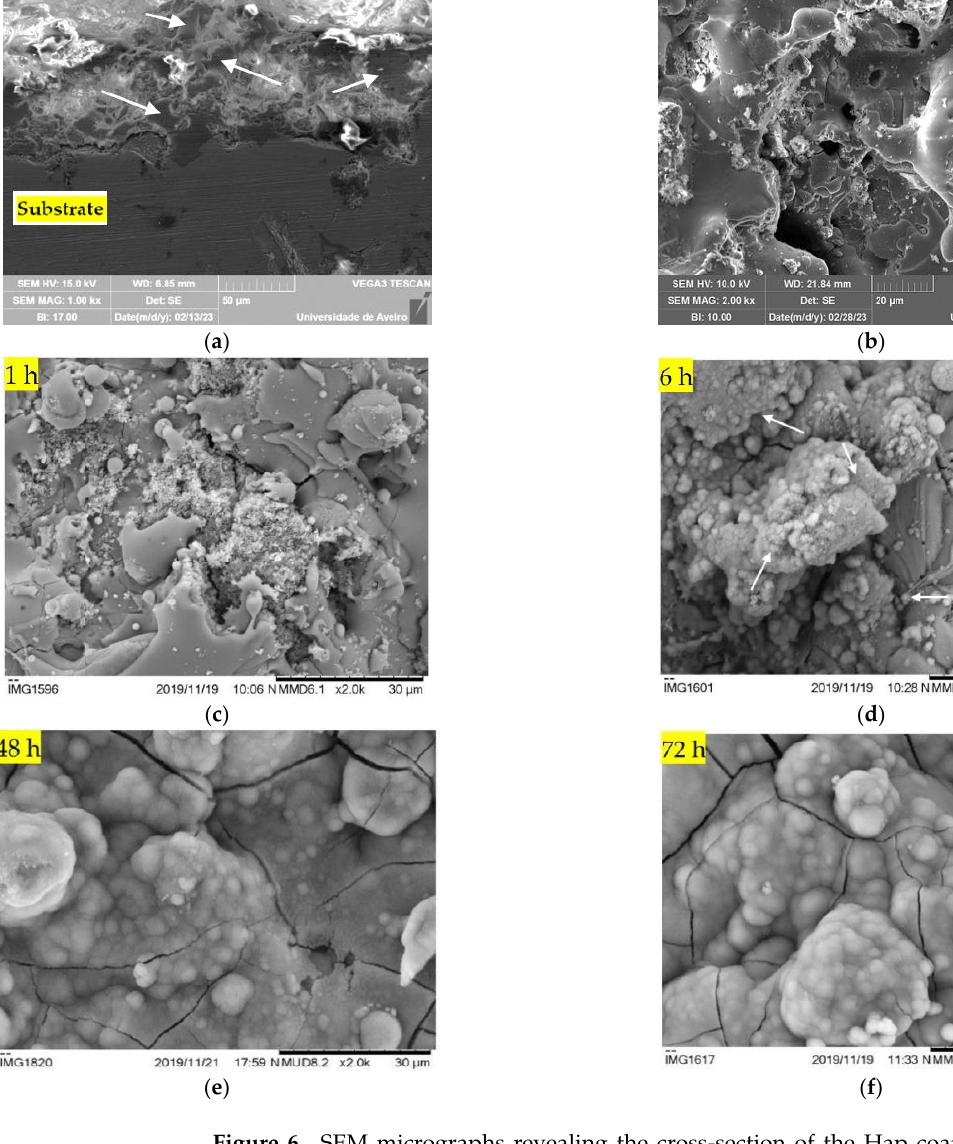
Figure 6. SEM micrographs revealing the cross-section of the Hap coating ( a ) and the surface morphology of the charged coatings for different immersion times: 0—no immersion ( b ), 1 ( c ), 6 ( d ), 48 ( e ) and 72 ( f ) hours. The arrows reveal bone-like carbonated Hap structures formation.